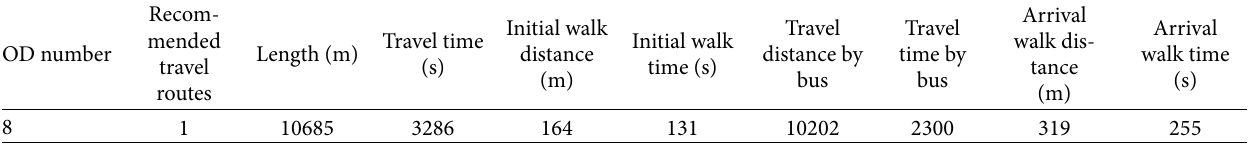
Table 1: Data sample of Baidu Maps Web API v2.0 for bus travelers.